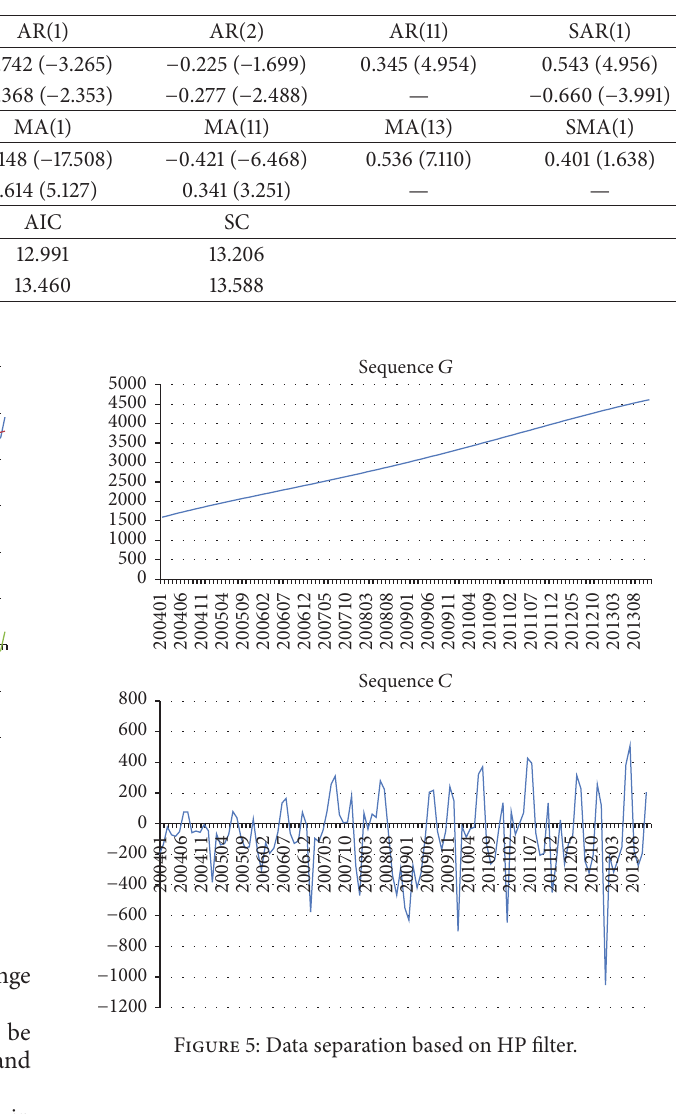
Table 2: The parameters estimate of the ARIMA model.